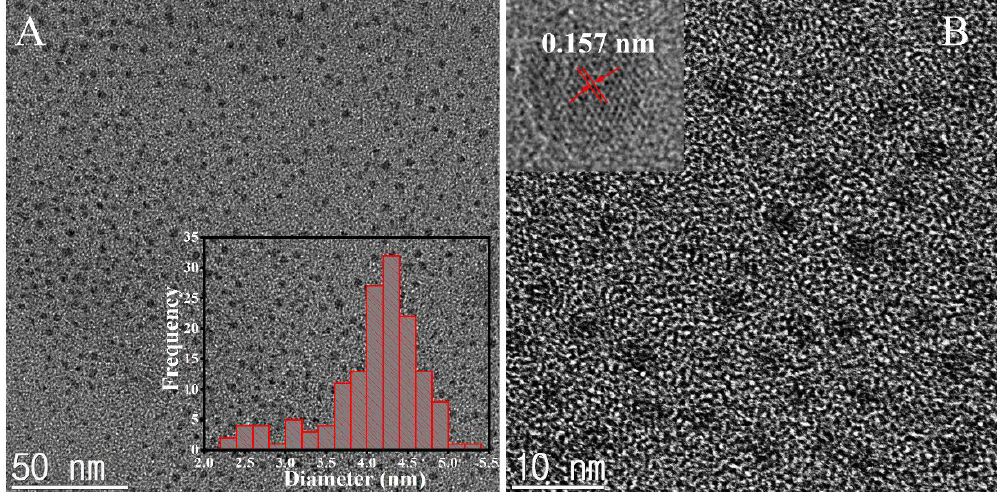
Figure 2. TEM images of NPCDs (inset ( A ) size distribution ( B ) HRTEM image of NPCDs).